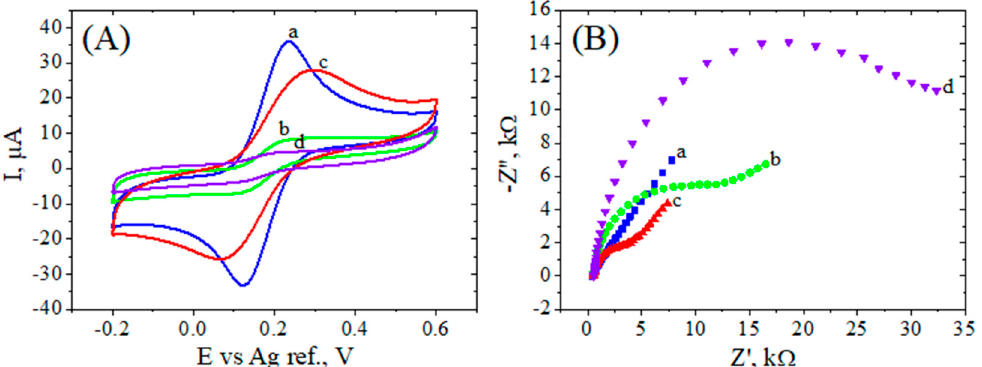
Figure 3. Electrochemical characterization for bare SPCE ( a ), GO/SPCE ( b ), RGO/SPCE ( c ), and Ar–COOH/RGO/SPCE ( d ) modified electrodes: CVs, 0.05 V/s ( A ) and EIS Nyquist plots at 0.16 V vs. Ag ref. ( B ) recorded in 1 mM [Fe(CN) 6 ] 3 − /4 − , 0.1M KCl.